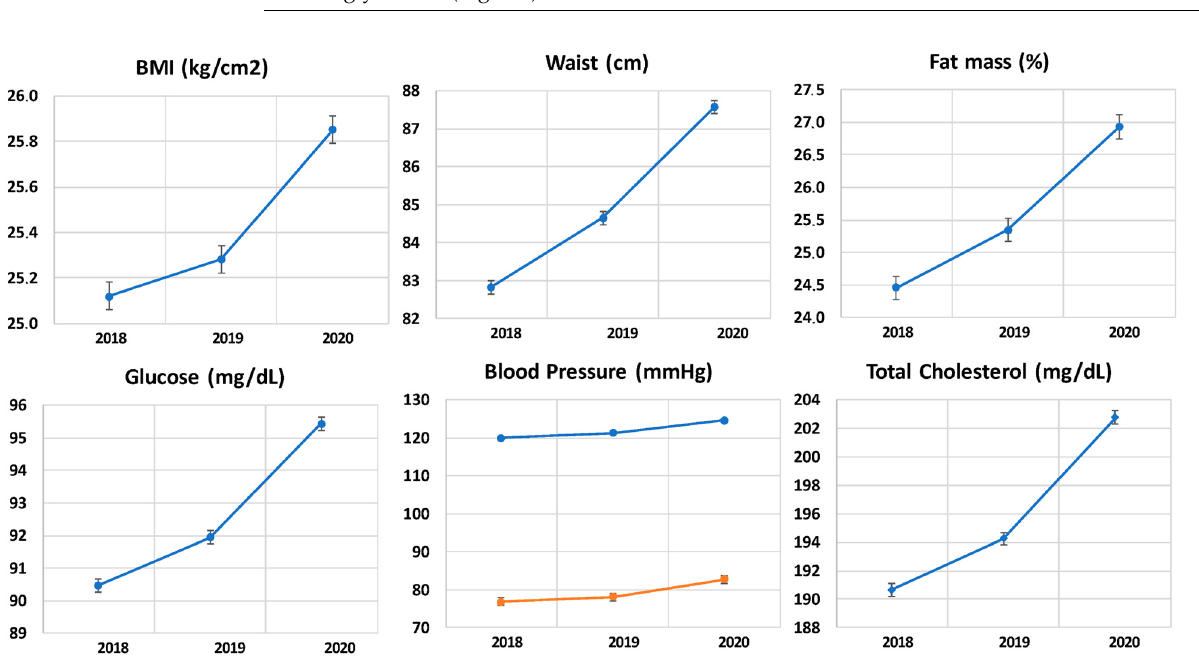
Figure 2. Changes in cardiovascular risk factors in 2018, 2019, and 2020: BMI, waist, lean mass, glucose, blood pressure, and total cholesterol.